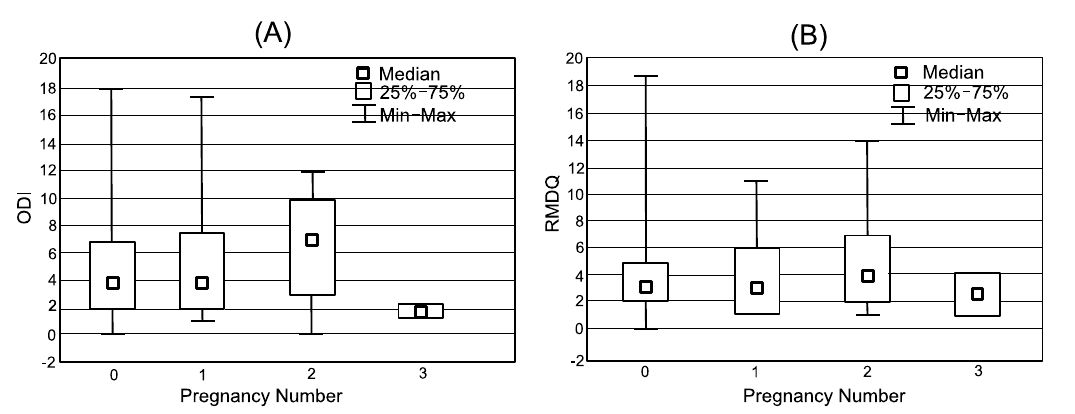
Figure 4. Relationship between number of pregnancies and pain intensity ( A ) ODI = the Oswestry Disability Index; ( B ) RMDQ = the Roland Morris Disability Questionnaire.